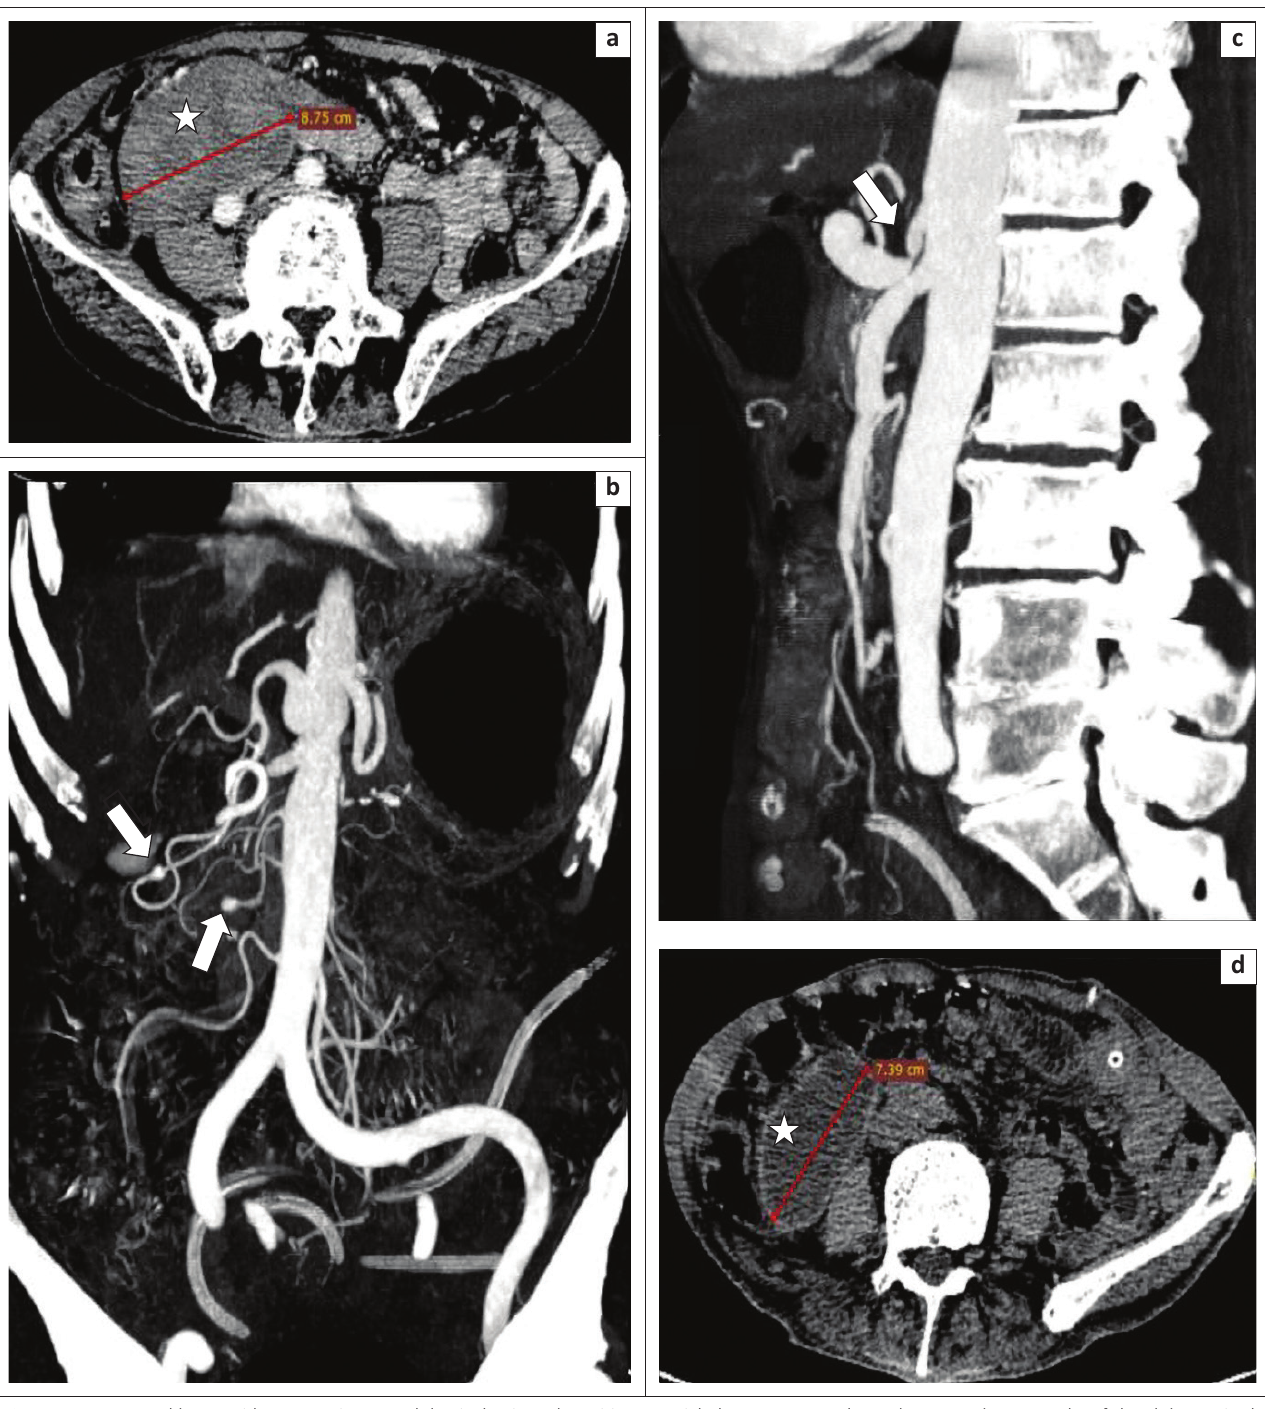
FIGURE 1: A 65-year-old man with atraumatic acute abdominal pain and vomiting: Arterial phase contrast enhanced computed tomography of the abdomen in the axial (a), coronal (b) and sagittal planes (c) show a well-orgnised mesenteric haematoma (asterix, a) of approximately 9 cm. Two small aneurysms were identified (arrows, b) originating from the upper and lower pancreatico-duodenal arteries. There was significant coeliac artery compression by the median arcuate ligament (arrow, c) resulting in post-stenotic fusiform dilatation of the celiac artery. Non-enhanced computed tomography in the axial plan (d), performed 2 months later, shows homogeous liquifecation of the haematoma with a well-distinguished regular and thin